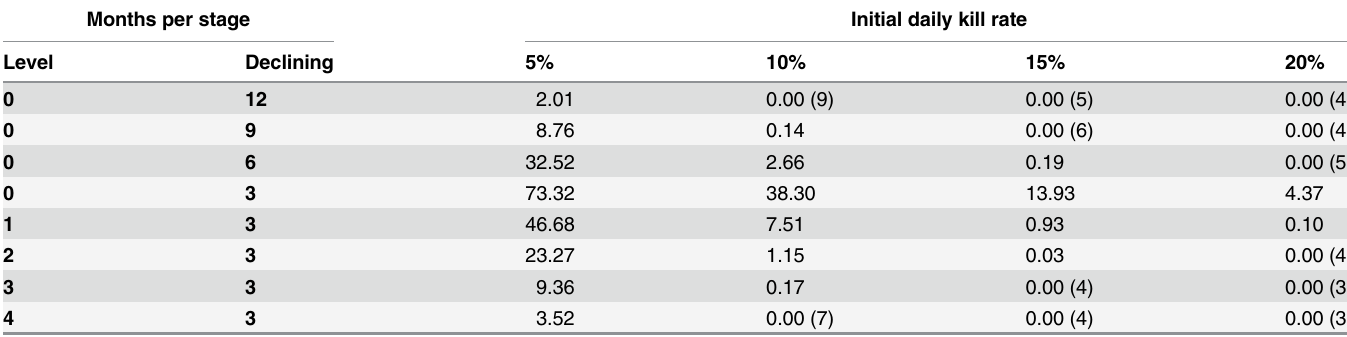
Table 1. Control achieved by different kill rates imposed in various seasonal patterns, in good isolated habitat. Months per stage